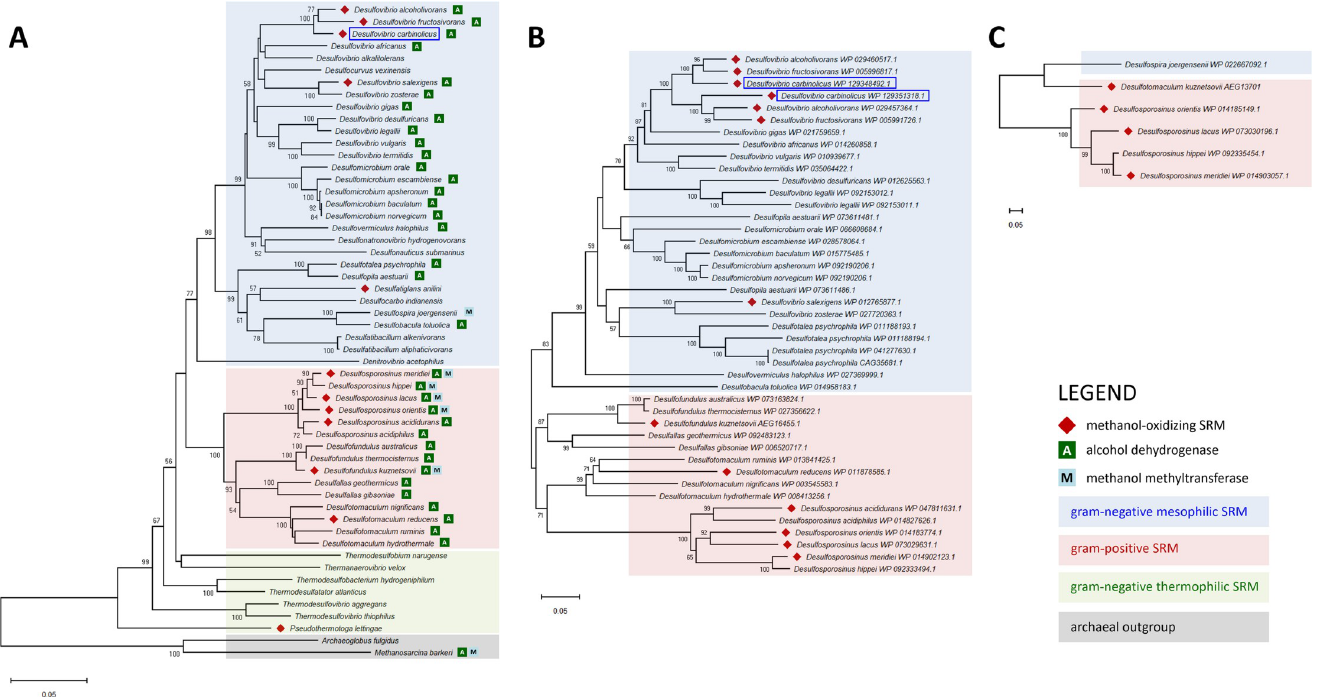
Fig 4. Phylogenetic tree of the selected sulfate-reducing bacteria based on 16S rRNA sequence (A) and of the genes encoding homologous proteins to methanol- oxidizing alcohol dehydrogenase (B) and methanol methyltransferase (C) of D . kuznetsovii [9]. This analysis involves 52 species of sulfate-reducing bacteria that have their genome sequenced and deposited in NCBI database and have been tested for methanol metabolism [3–8, 12, 49, 55–88]. The trees were constructed using MEGA X software with the neighbor-joining method. Numbers before each branch point represents the percentage of bootstrap resampling based on 2,000 trees. Bootstrap values below 50% are not shown. D . carbinolicus examined in this study is highlighted in a blue box. https://doi.org/10.1371/journal.pone.0245069.g004 dehydrogenase but no methyltransferase genes fall into the Desulfovibrio genus, and their